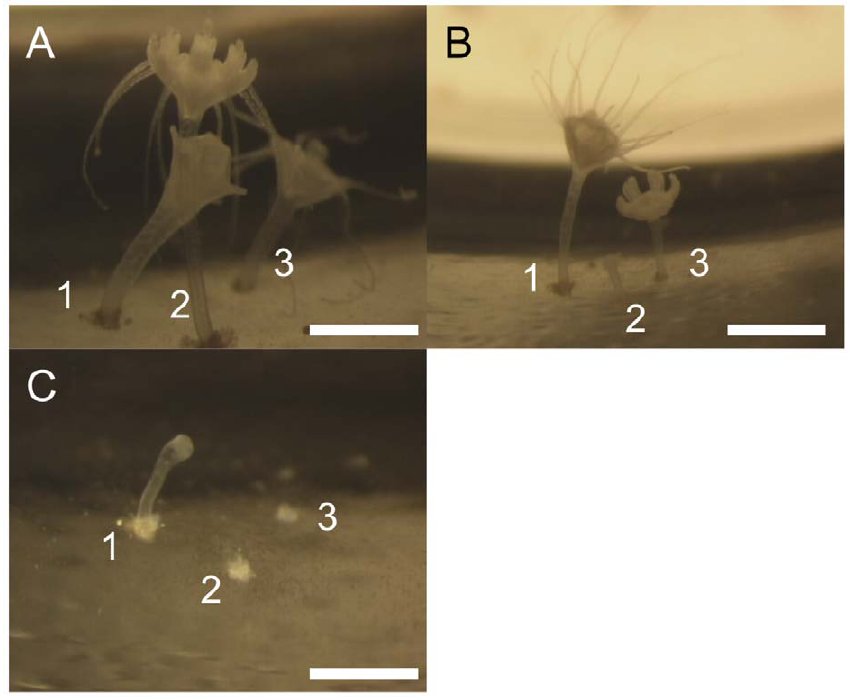
Figure 8. Developmental sequence of strobilating polyps. A ) Polyp # 1 after 1 day of strobilation, # 2 in monodisc strobilation and # 3 completely developed. B ) Polyp # 1 completely developed after 26 days of strobilation, # 2 only stalk after liberating the ephyra and # 3 in monodisc strobilation. C ) Polyp # 1 only stalk after liberating the second ephyra 40 days after liberating the first one, # 2 and # 3 died and only prints where pedal discs were attached are observed. All scale bars =500 m m. Author of the pictures: D.